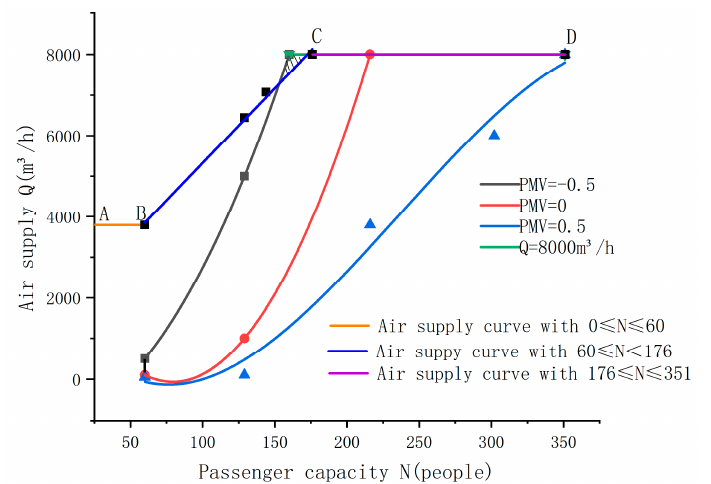
Figure 5. Air supply volume range based on cooling and fresh-air volume requirements. The shaded areas indicate the air-supply volume, which meets both the PMV between ( − 0.5, 0.5) and the cooling and fresh-air volume